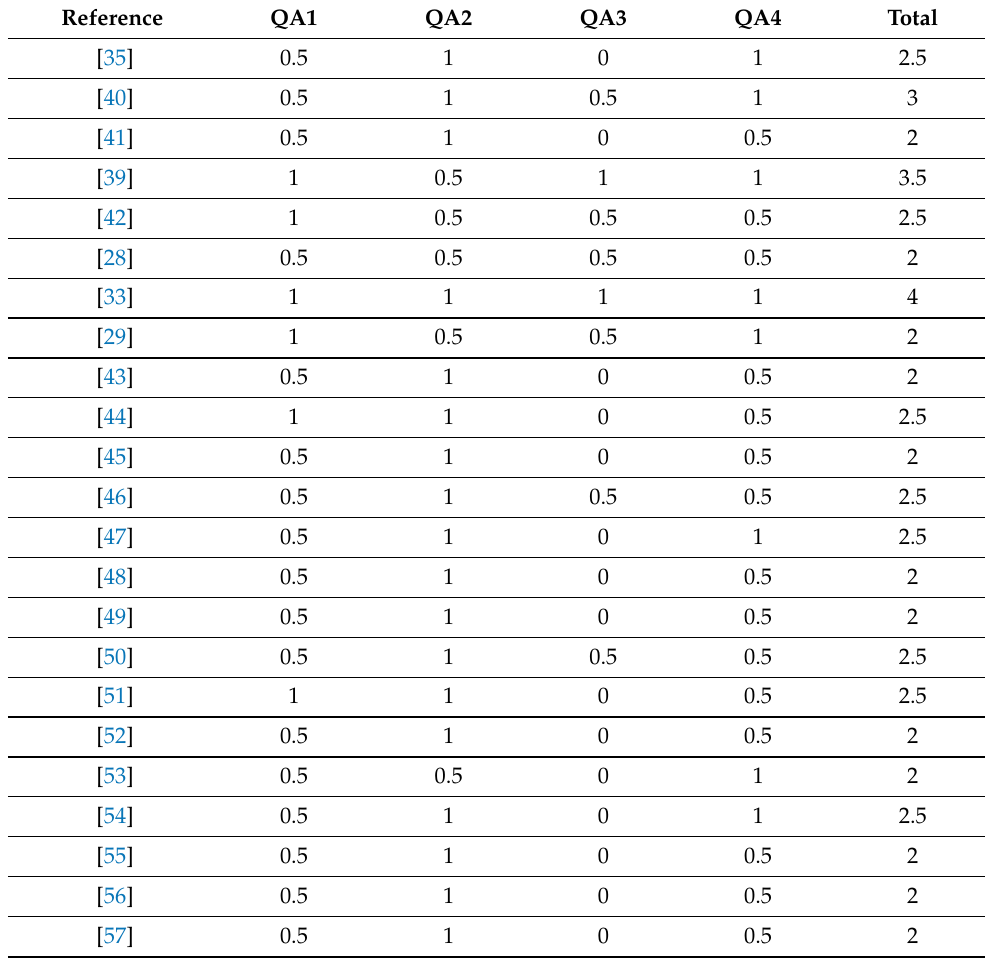
Table 2. Summary of quality assessment for selected studies.